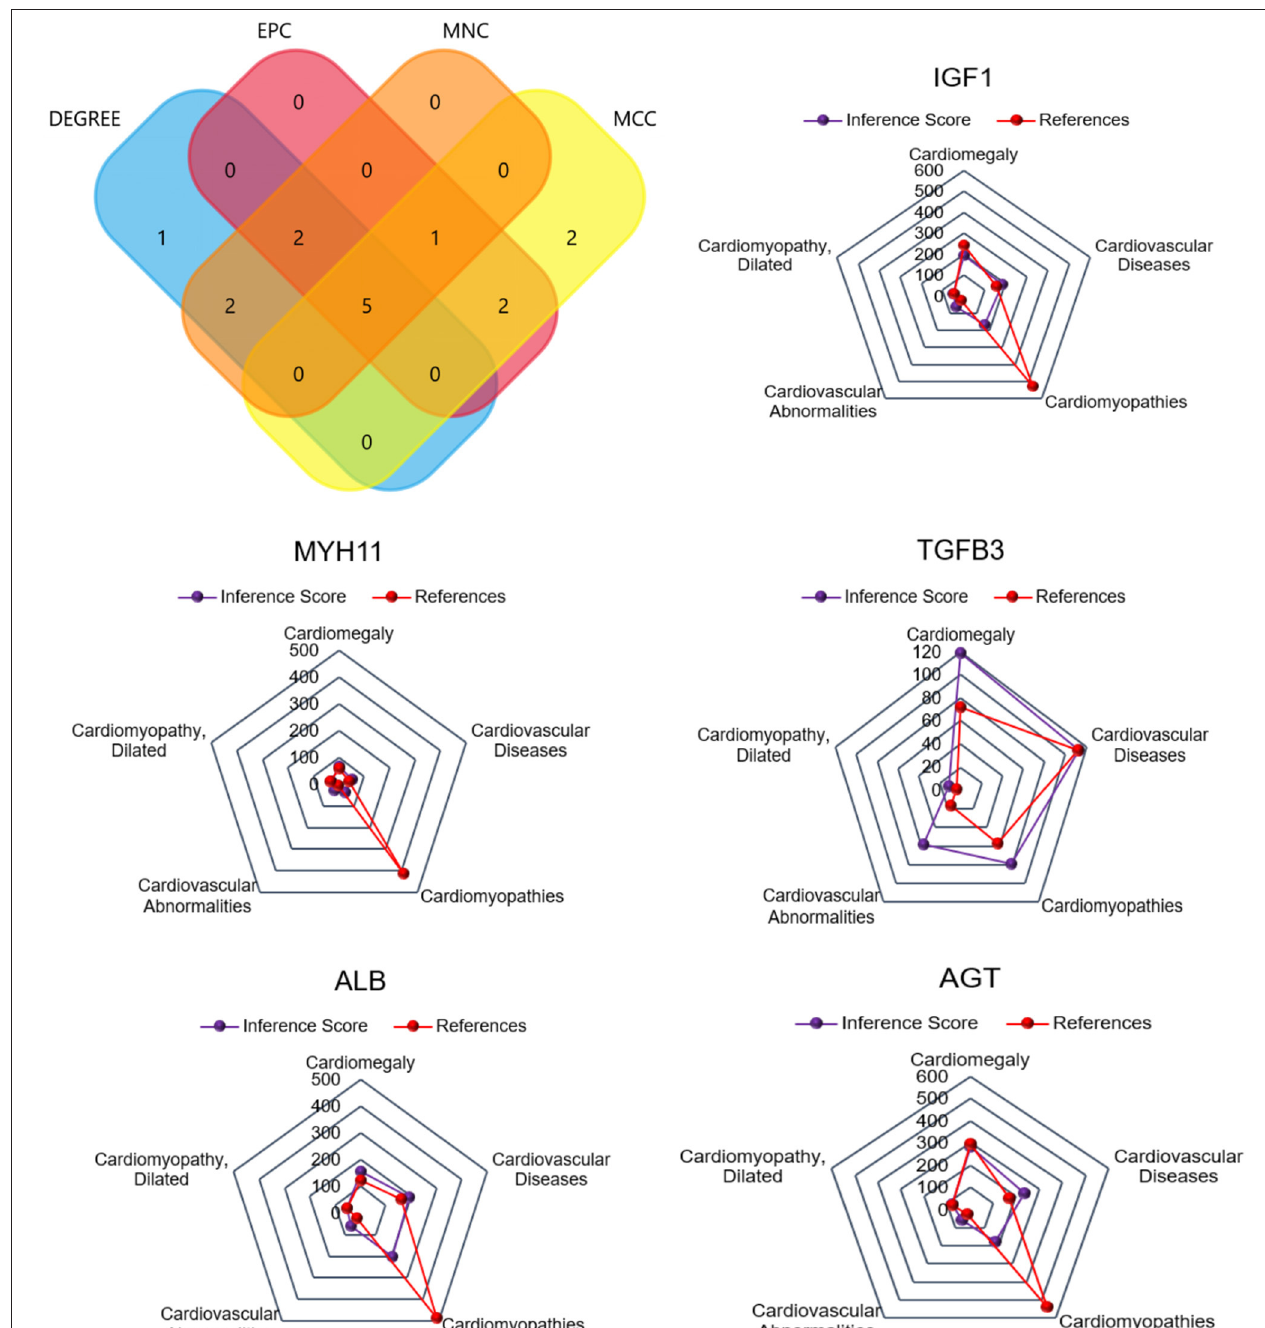
FIGURE 6 | The common hub genes identified from degree, edge percolated component (EPC), maximal clique centrality algorithm (MCC), and maximum neighborhood component (MNC) analysis of Ang II vs. CFs. IGF1, MYH11, TGF β 3, ALB, and AGT were identified as related to cardiovascular disease based on the CTD